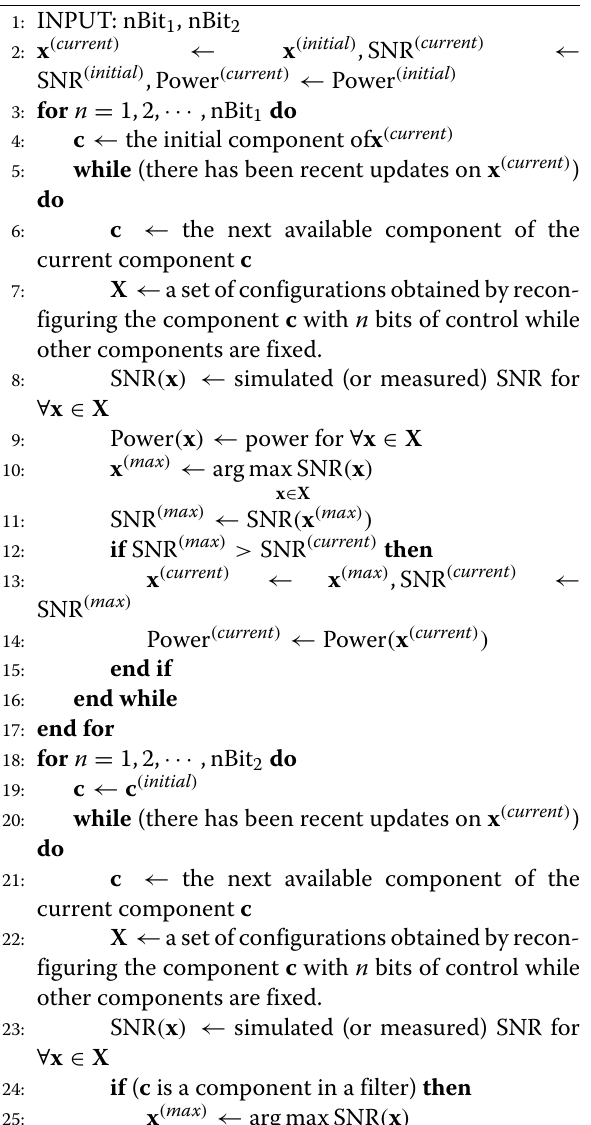
Algorithm 3 Multi-Resolution Algorithm Algorithm 4 EAF Multi-Resolution (EAF-MR)